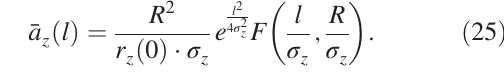
FIG. 8. Plots of the normalized density at z ¼ 0 , x ¼ 0 . 1 r y ¼ 0 . 1 r as functions of ¯ a (horizontal axis), and φ y z t ¼ π . The distributions are normalized to their (vertical axis) ω p ¼ 0 . The contour lines are spaced by values at ¯ a z